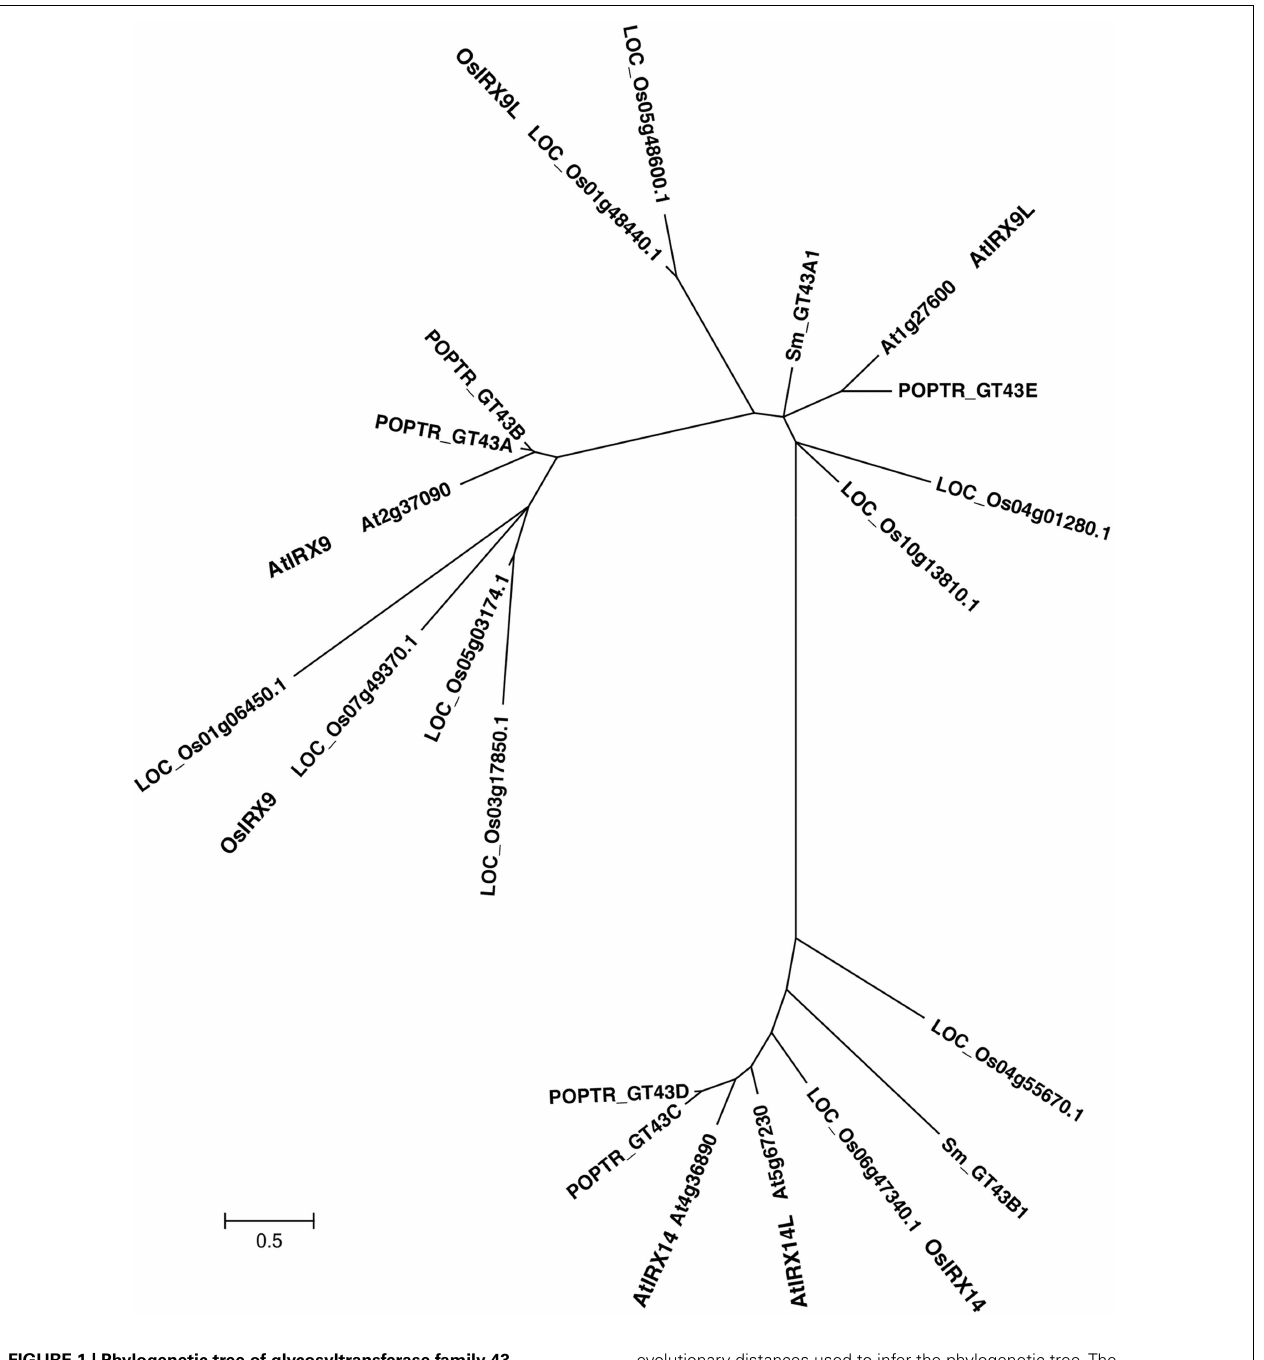
FIGURE 1 | Phylogenetic tree of glycosyltransferase family 43 including genes from rice, Arabidopsis , Poplar, Selaginella , and Physcomitrella genomes. The evolutionary relationships were inferred using the Neighbor-Joining method.The optimal tree with the sum of branch length = 16.96637902 is shown.The tree is drawn to scale with branch lengths in the same units as those of the